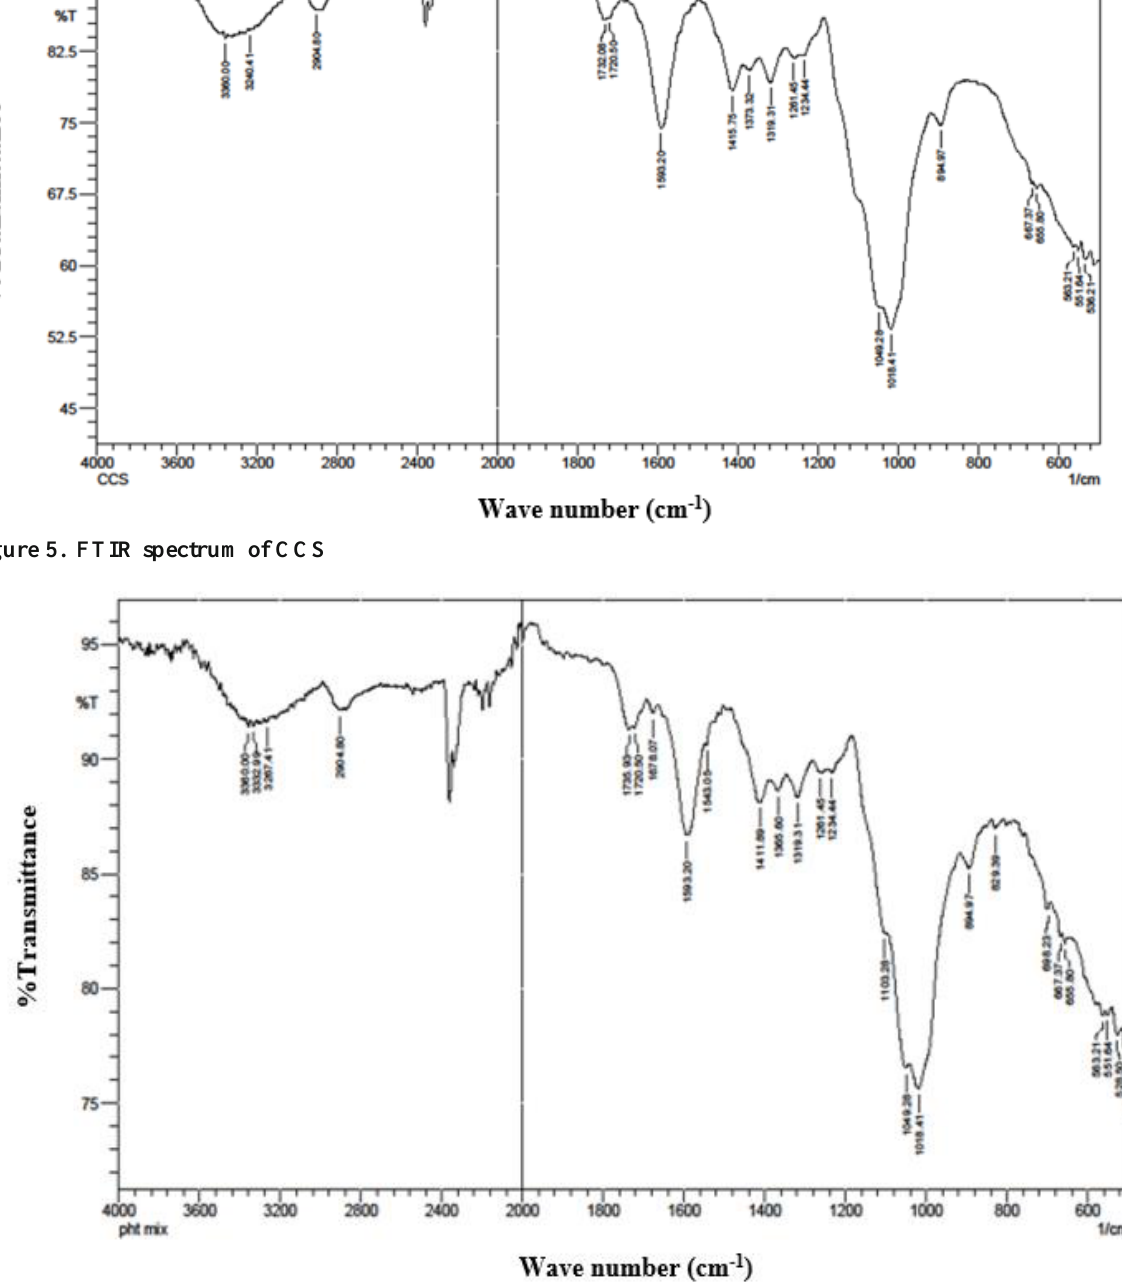
Figure 6. FTIR spectrum of